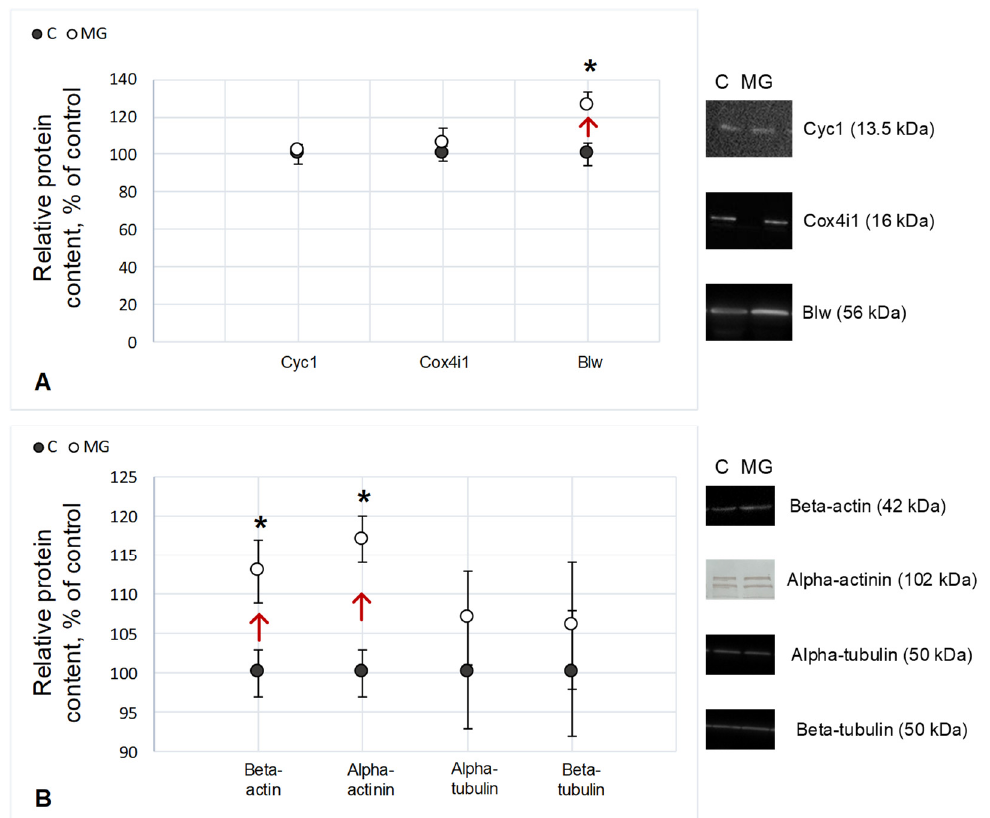
Figure 2. The relative content of proteins with typical Western blots. ( A ) Proteins involved in cellular respiration of Drosophila melanogaster ovaries. Cyc1 (13.5 kDa)—cytochrome c-1, a respiratory chain protein located between complexes III and IV; Cox4i1 (16 kDa)—cytochrome c oxidase, a protein of complex IV of the respiratory chain; Blw (56 kDa)—the subunit of ATP synthase F1. ( B ) Cytoskeletal proteins of the Drosophila melanogaster ovary. Beta-actin (42 kDa)—microfilament network component; alpha-actinin (102 kDa)—microfilament network component; alpha- and beta-tubulin (50 kDa)—microtubule network components; C—control group; MG—group of simulated microgravity. Arrows indicate the direction of change. * p < 0.05 compared to the control group C.